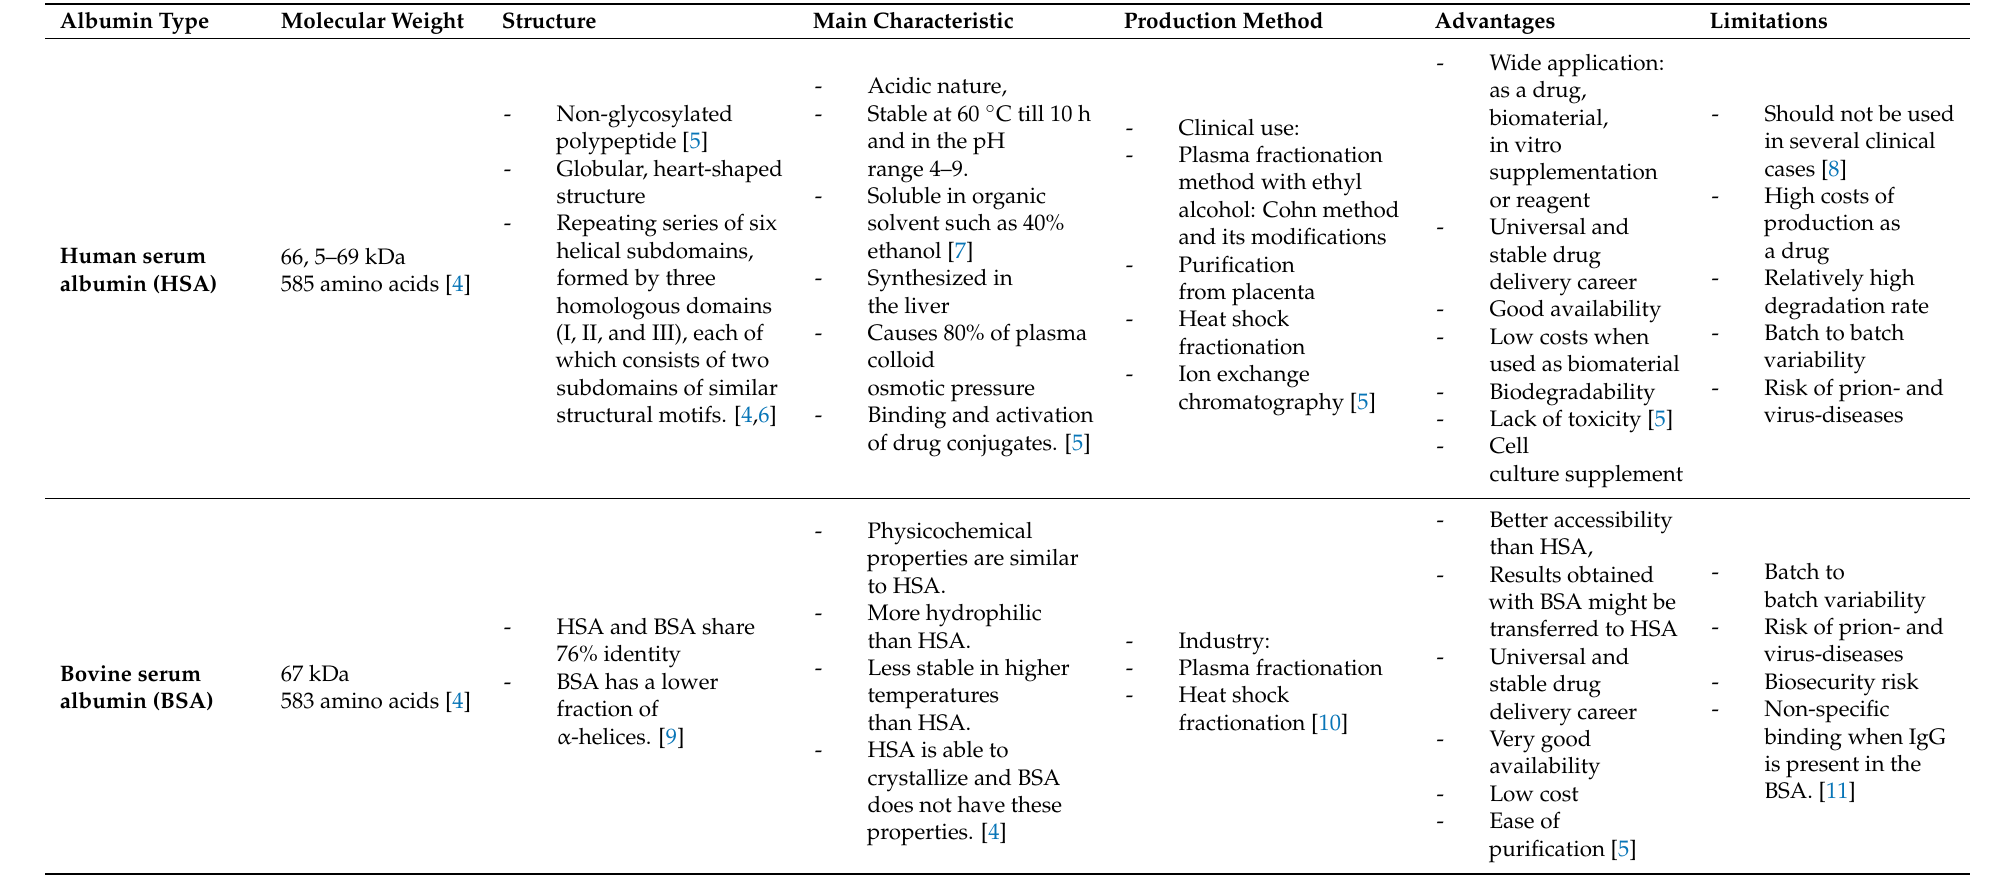
Table 1. Different albumin types and their